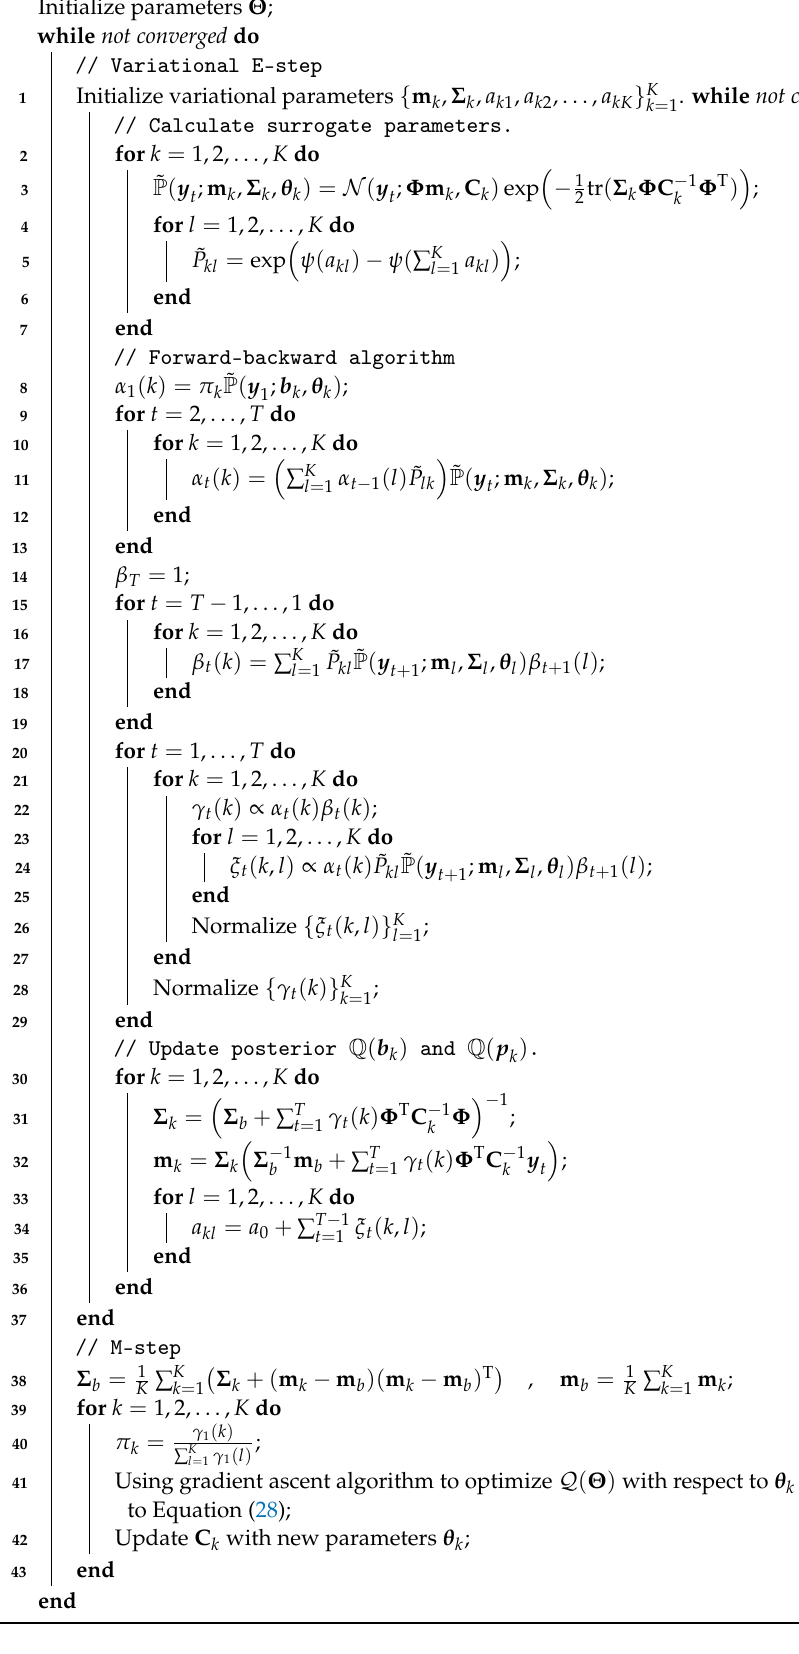
Algorithm 2: The variational EM algorithm for learning